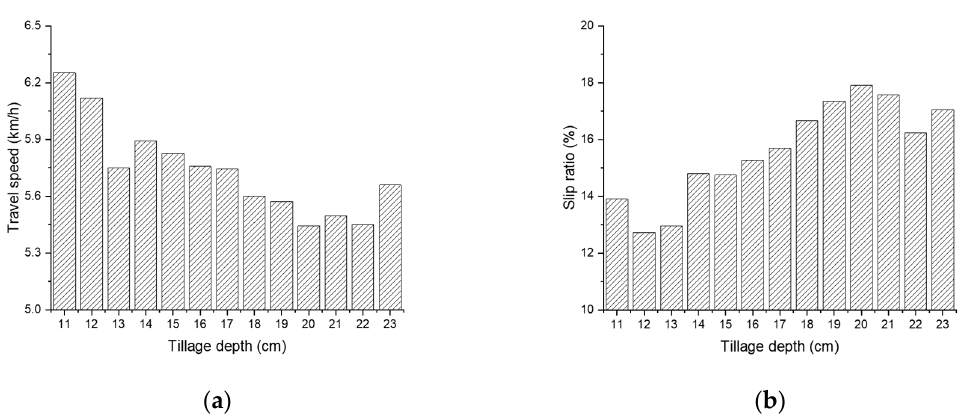
Figure 7. Overall mean ( a ) travel speed, and ( b ) slip ratio of agricultural tractor according to tillage depth during moldboard plowing.